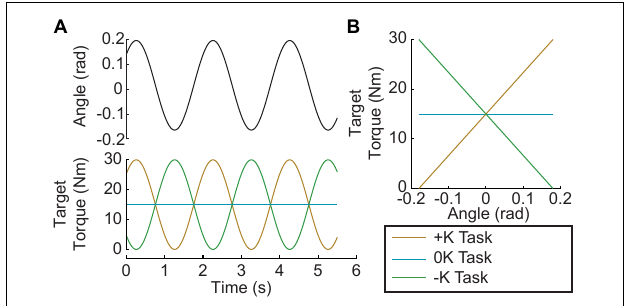
FIGURE 2 | Experimental Protocol. Subjects performed 3 tasks: A positive-quasi-stiffness task (+K); a zero-quasi-stiffness task (0K) and negative-quasi-stiffness task (–K). (A) In the +K task the target torque was in phase with the imposed sinusoidal ankle rotation, while it was out of phase for the –K task. (B) In the +K task, the slope of the target torque-angle trace is positive, thus we termed it a positive-quasi-stiffness task. Similarly, the